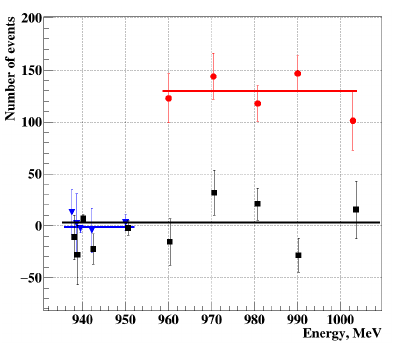
Figure 6: Counting number of p ¯ p events for di ff erent energy beam. Blue dots (-1.6 ± 3.2) - number of p ¯ p events inside signal region by time below E threshold ; Red dots (129.5 ± 9.2) - number of p ¯ p events inside signal region by time above E threshold ; Black dots (2.9 ± 3.1) - number of p ¯ p events outside signal region by